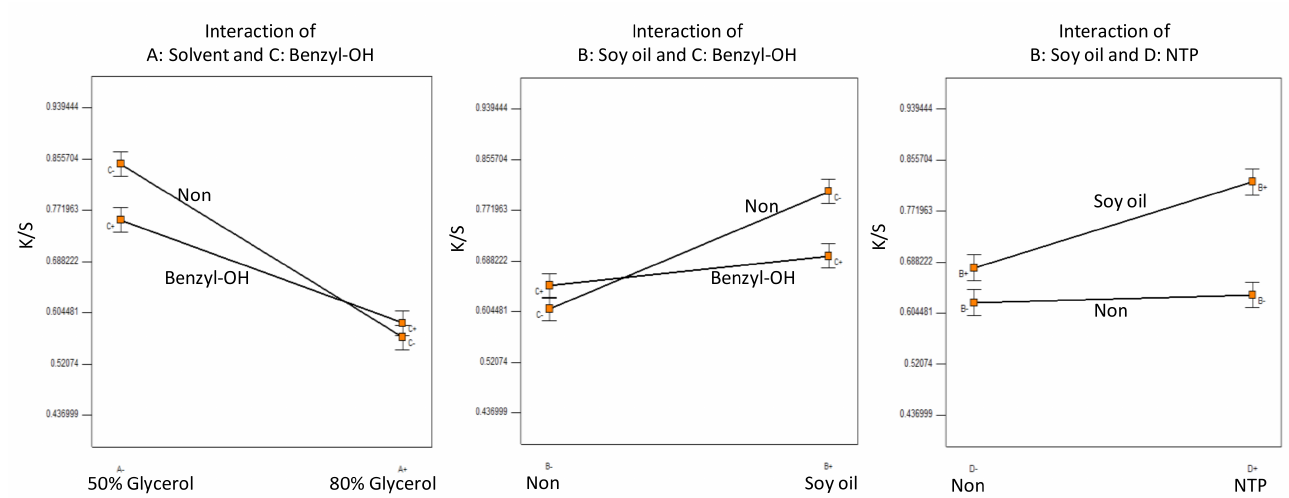
Figure 3. Statistical inference of Experiment B: significant factorial